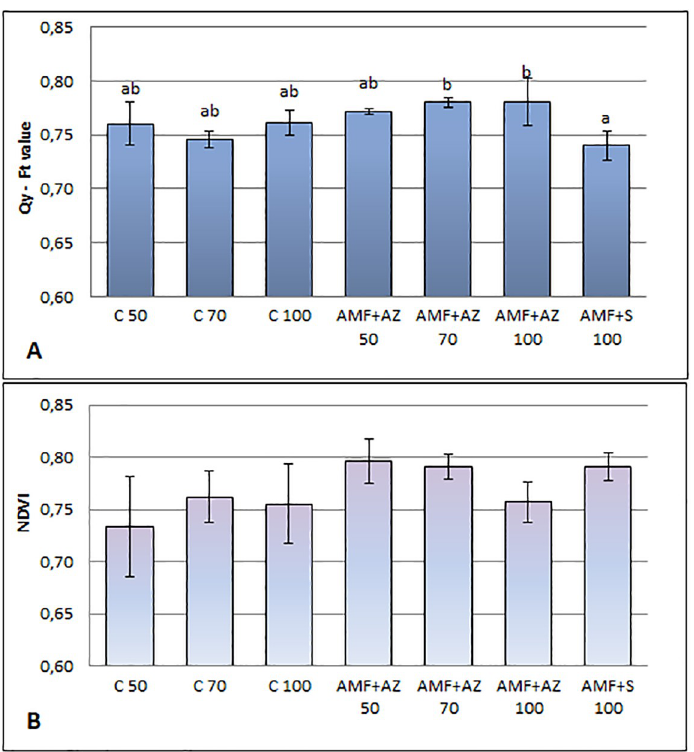
Fig 3. Effects of soil microorganisms application to substrates of different organic matter content on Quantum Yield (QY) (A) and Normalized Difference Vegetation Index (NDVI) (B) in tomato leaves transplants. Means followed by different letters are significantly different at P � 0.05, with comparisons performed by Fisher’s LSD test. Error bars represent the standard deviation ( ± SD) for interaction. C 50 –peat:sand ratio 50:50 (v:v)